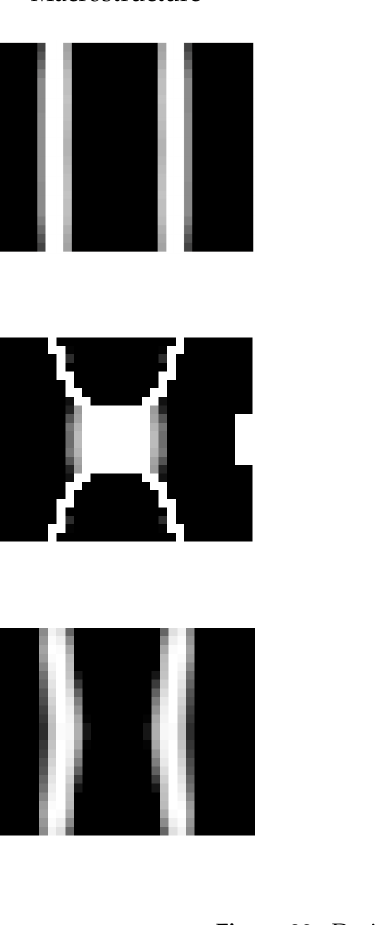
Figure 20. Design results for different optimization objectives: ( a ) Objective 1: maximizing the first modal loss factor; ( b ) Objective 2: maximizing the second modal loss factor; ( c ) Objective 3: maximizing the sum of the first two modal loss factors. Table 5. Comparison of the modal loss factors between optimized structure and full coverage structure (bold italics denote the modal loss factor of objective